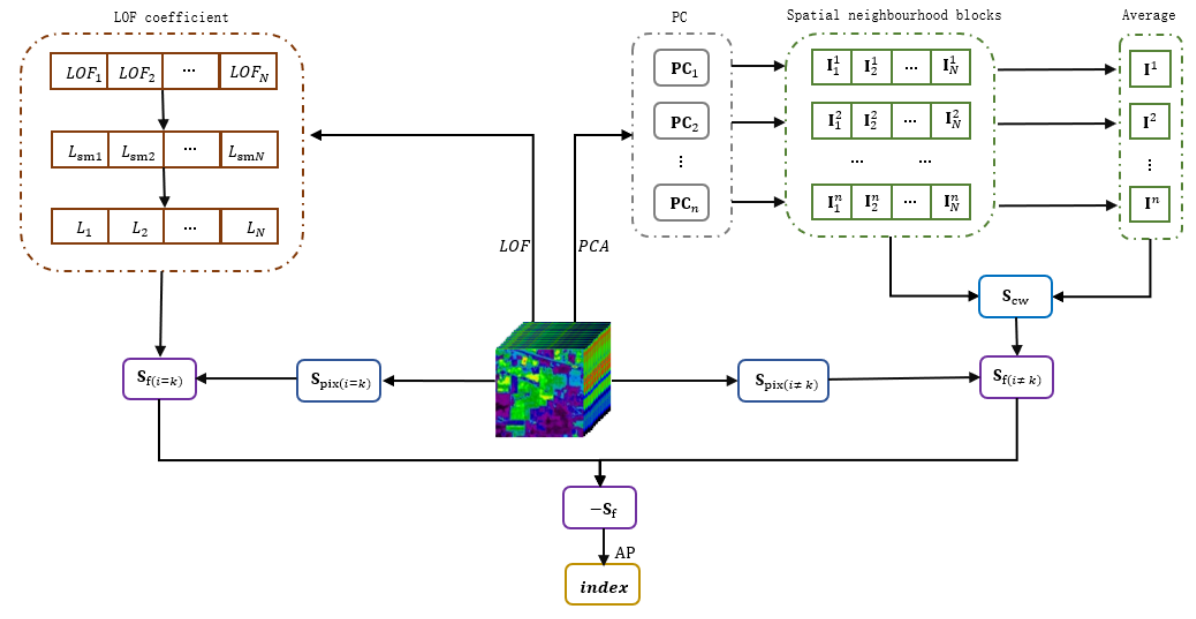
Figure 1. The flow chart of the affinity propagation based on the structural similarity and local outlier factor.